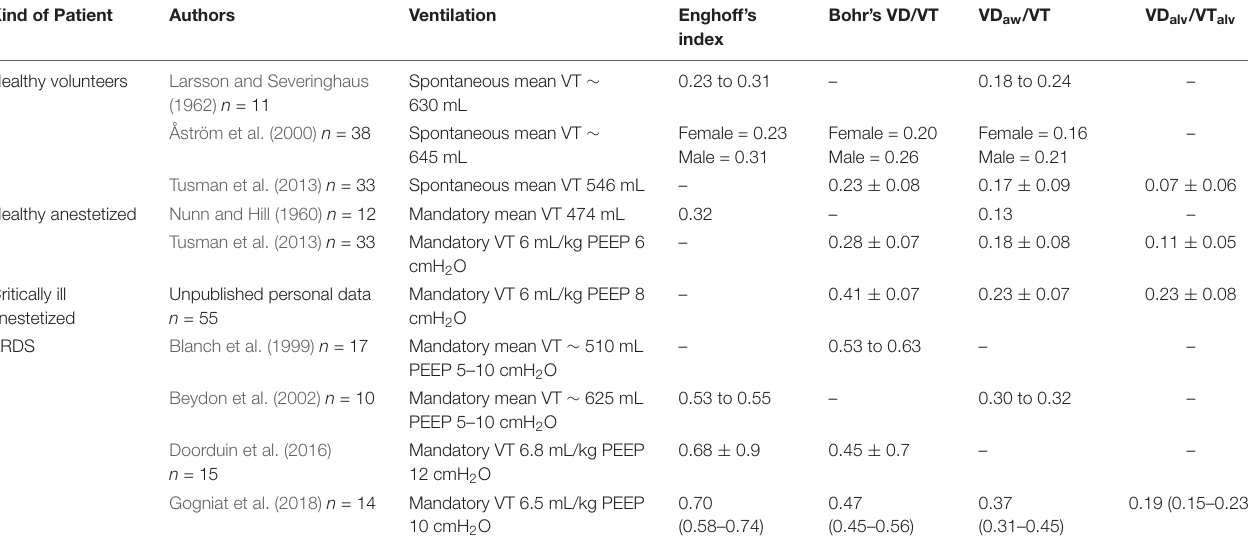
TABLE 1 | Published values of measured Bohr’s and Enfhoff’s approaches using capnography. Kind of